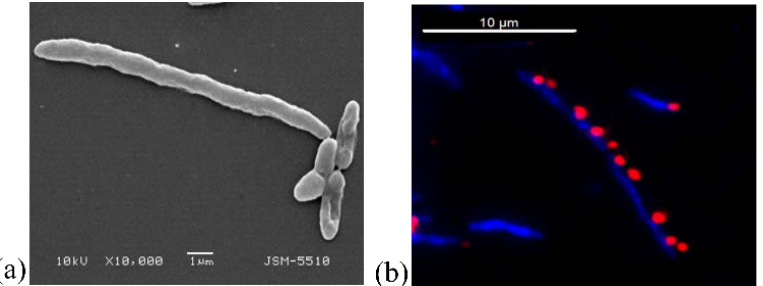
Figure 12. Illustration of long cells (results of blocking of division of cells) of E. coli NBIMCC 8785 after 6 h treatment with 10% peptide fraction, MW < 10 kDa: ( a ) SEM analysis at 10,000 × ; ( b ) fluorescence analysis, with the cells stained with DAPI and CTC.